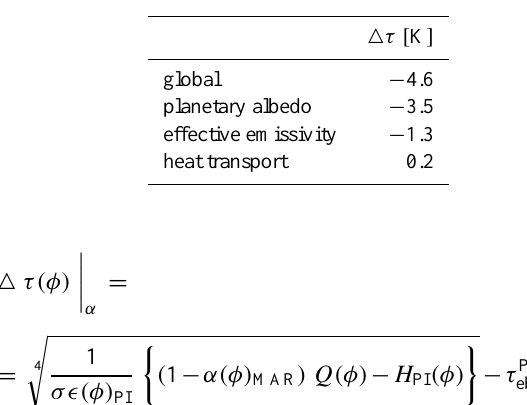
Table 4. Global annual-mean surface temperature difference be- tween the Marinoan (MAR) and pre-industrial (PI) control simula- tions as diagnosed by the one-dimensional energy balance model. 4 τ [ K ] global − 4.6 planetary albedo − 3.5 effective emissivity − 1.3 heat transport 0.2